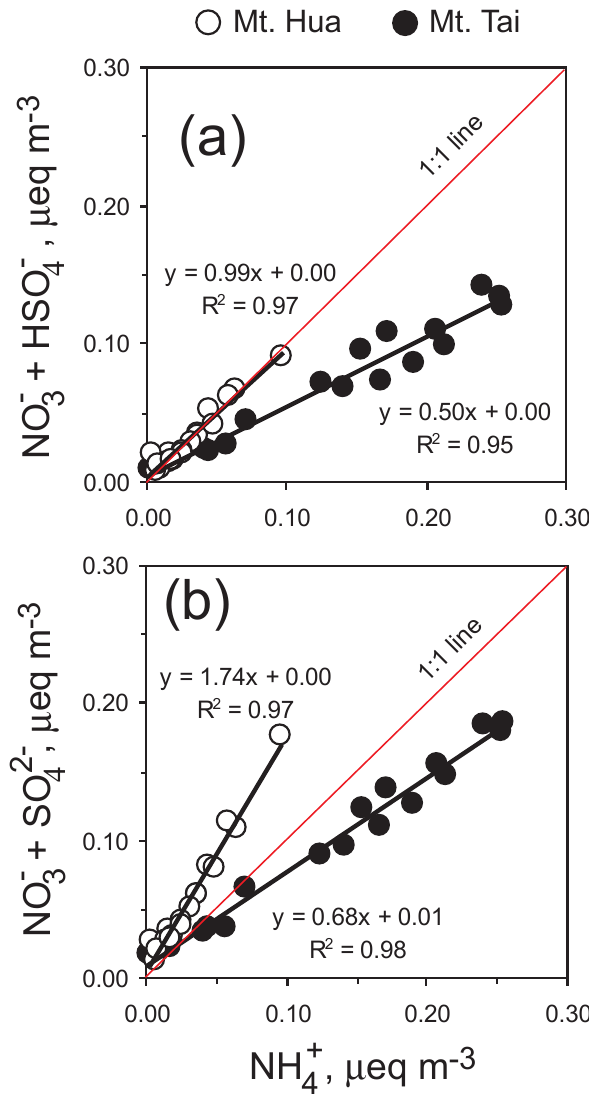
Fig. 11. Equivalent ratios of ammonium to (a) the sum of nitrate and bisulfate and (b) the sum of nitrate and sulfate in particles with a diameter less than 2.1µm at Mt. Hua and Mt. Tai during the whole sampling time including the non-dust storm and dust storm periods.